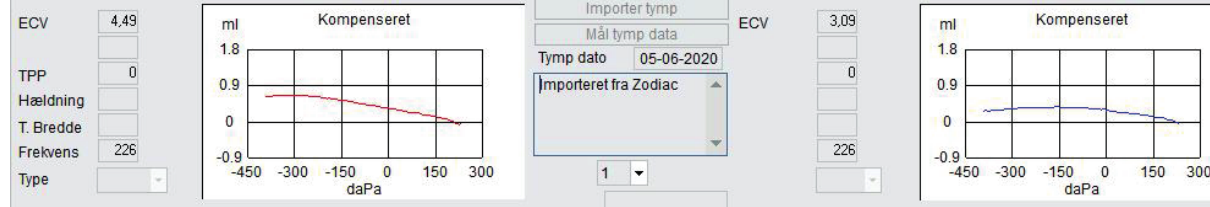
Figure 4. Tympanogram during Dupilumab treatment. Type B curves are still present on both sides, but ear canal volumes (ECV) are now large indicating functioning ventilation tubes and air-filled middle ears on both right and left side (red and blue